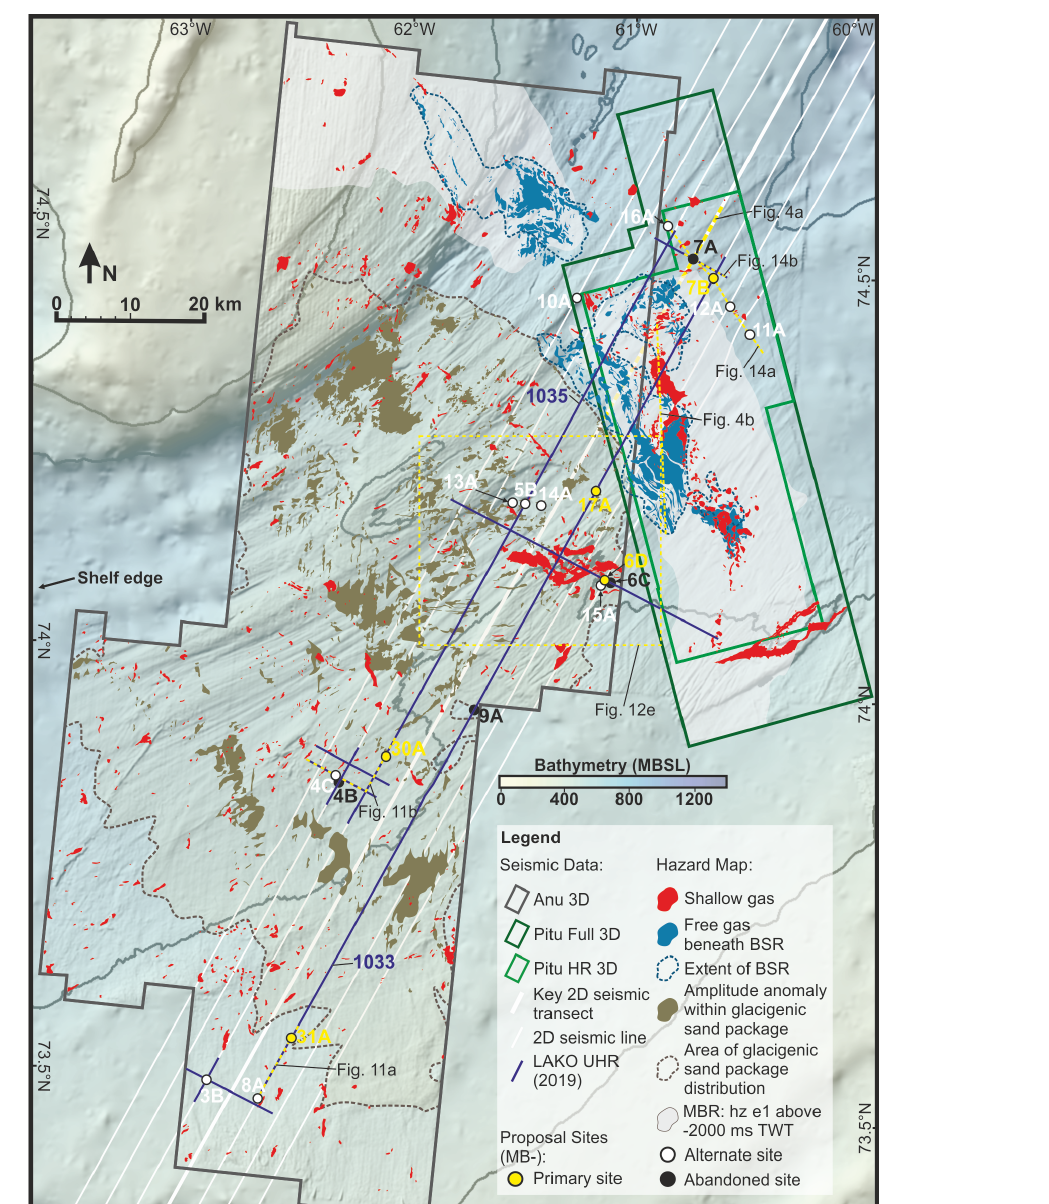
Figure 3. A fluid hazard and data map of the study area displaying the regional bathymetry from Newton et al. (2017) as well as the location of all seismic data used within the Proposal 909 study. The locations of potential fluid anomalies were identified and mapped via the shallow gas detection process within the geohazard assessment workflow. Active and abandoned IODP Proposal 909 sites that exist within the 3D seismic extent are shown as well as the location of the Melville Bay Ridge (MBR) and Figs. 4a, b, 11a, b, 12e, 14a and